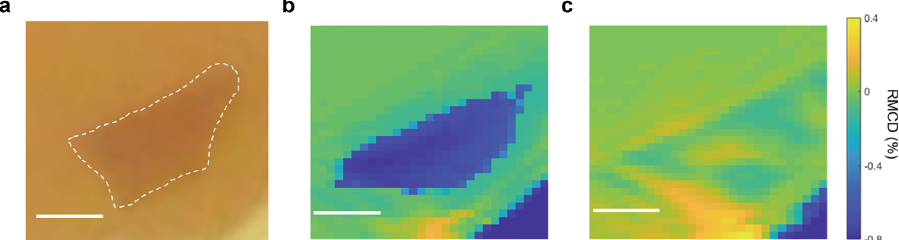
Fig. 3 Optical image and magnetic domain patterns of a 4 L Fe 3 GeTe 2 . a 4 L Fe 3 GeTe 2 fl ake whose contour is circled out in the white dashed line. b , c Scanned RMCD images of the corresponding 4 L fl ake before and after a 10-min treatment, respectively. The data is taken at 130 K upon a zero- fi eld cooling. Scale bars in ( a ) – ( c ), 3 μ